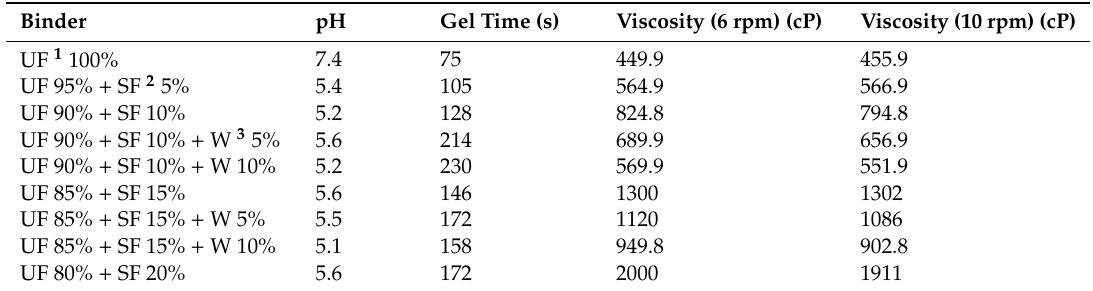
Table 4. Properties of the 12 resin mixtures used to manufacture three-layer plywood.